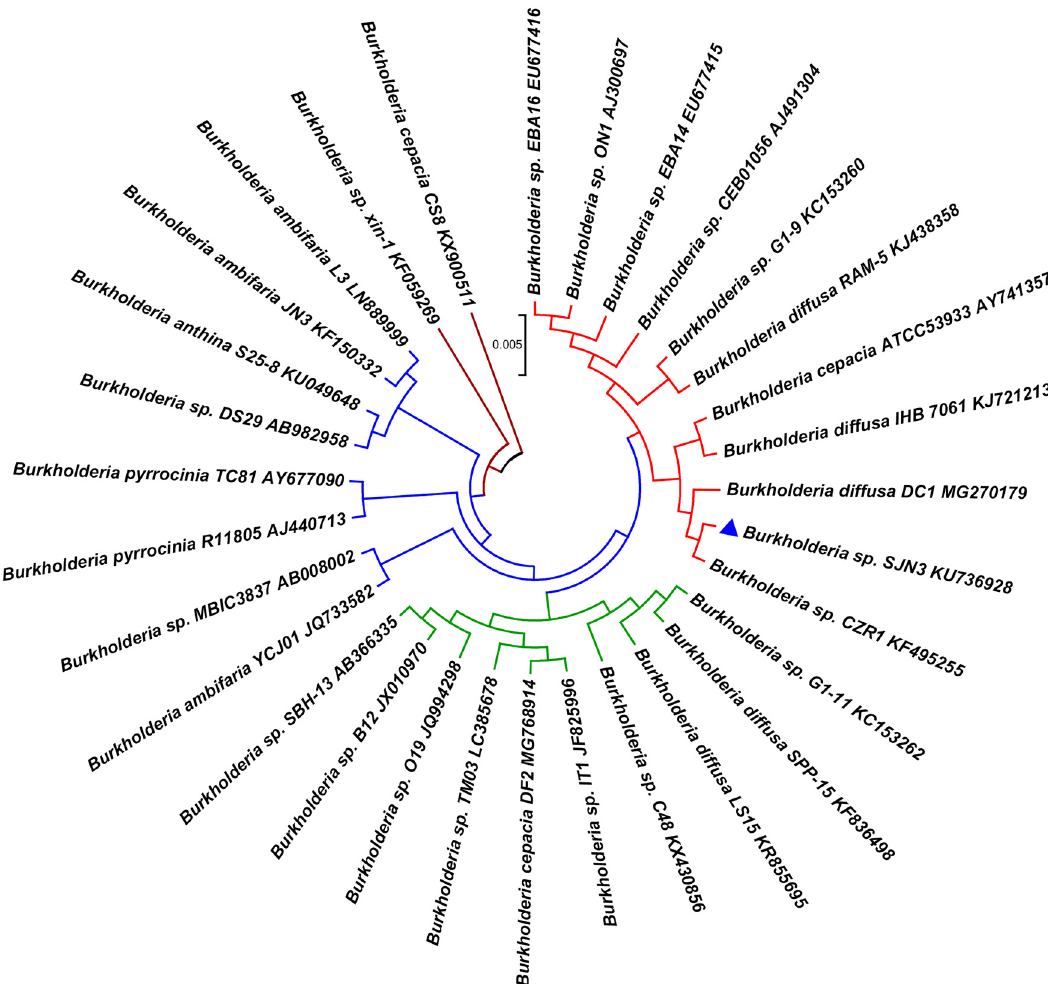
Figure 1: Phylogenetic tree was constructed based on 16S rDNA sequences among neighboring species using the neighbor - joining method with MEGA version 6.0 ( www.megasoftware.net ) . Bootstrap percentage values were obtained from 2000 resamplings. The bar represents 0.005 substitutions per nucleotide position. Sequences with high similarity scores were downloaded from the NCBI ( http://blast.ncbi.nlm. nih.gov/Blast.cgi )